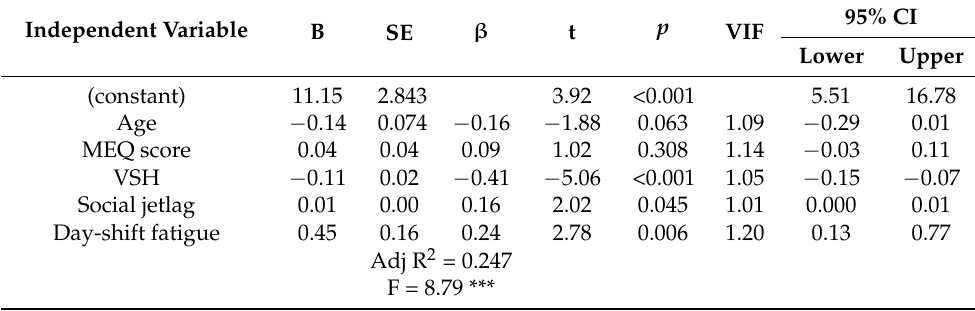
Table 4. Influence of monthly average sleep quality. Independent